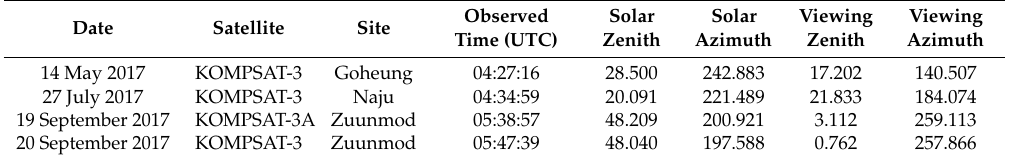
Table 2. Selected geometric conditions of KOMPSAT-3 and -3A imagery for radiometric calibration.